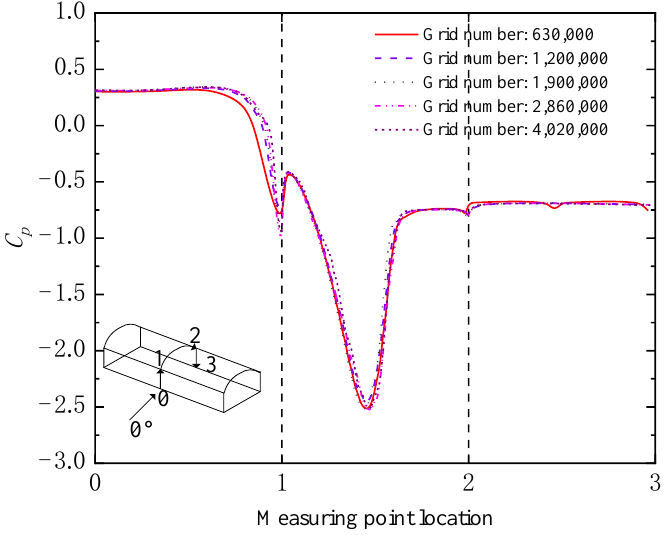
Figure 6. Comparison of wind pressure coefficients for different grid sizes.